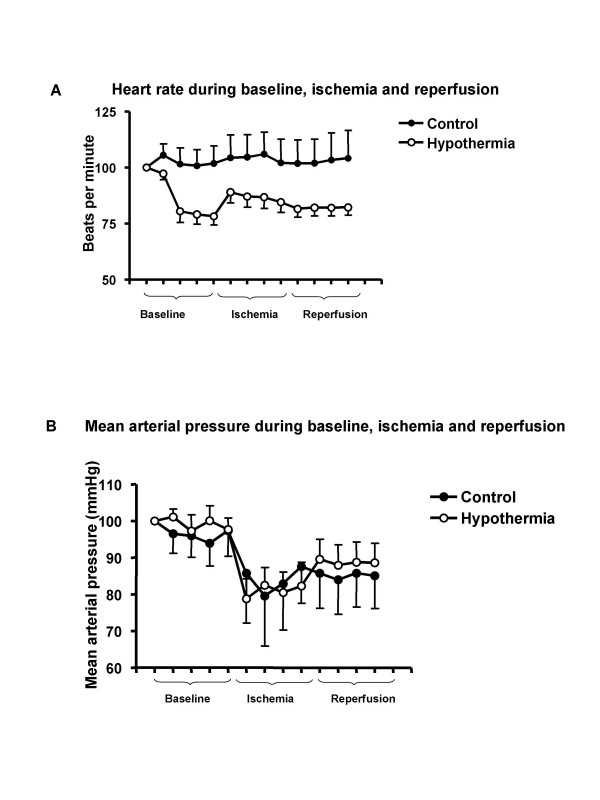
Heart rate and mean arterial pressure during baseline, ischemia and reperfusion. Heart rate (HR) was measured during baseline, ischemia, and reperfusion in both the normothermic (n = 8) and the hypothermic (n = 8) pigs. During the entire period of hypothermia HR was lower in the hypothermic group (A). Mean arterial pressure, expressed as mm/Hg, was similar, and reduced in both groups during ischemia and reperfusion compared to baseline (B).